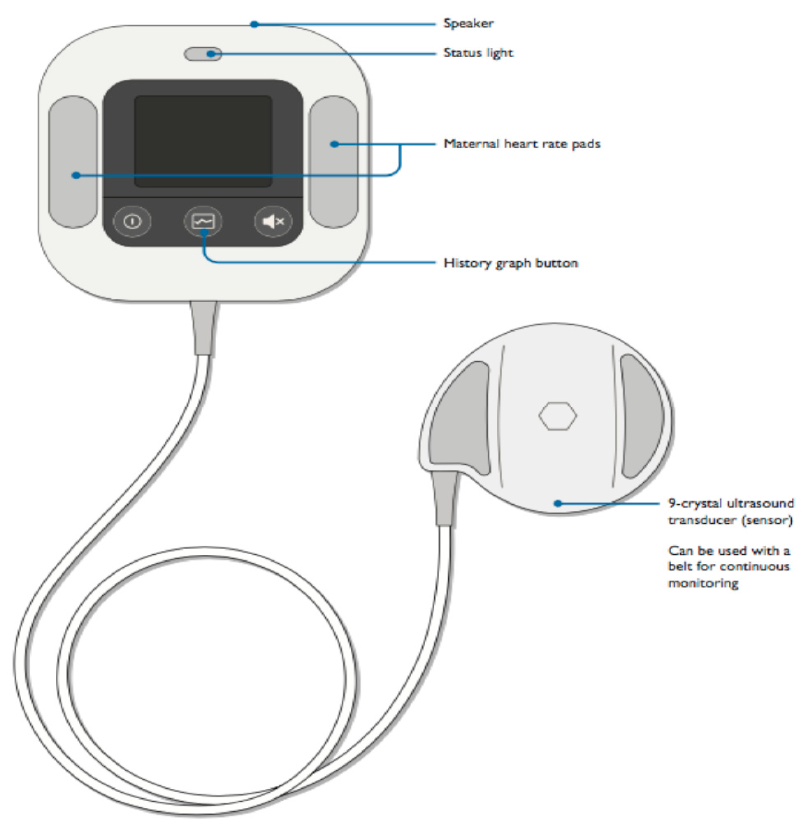
Figure A1. The Fetal Heart Rate (FHR) monitor, Moyo (Laerdal Global Health).